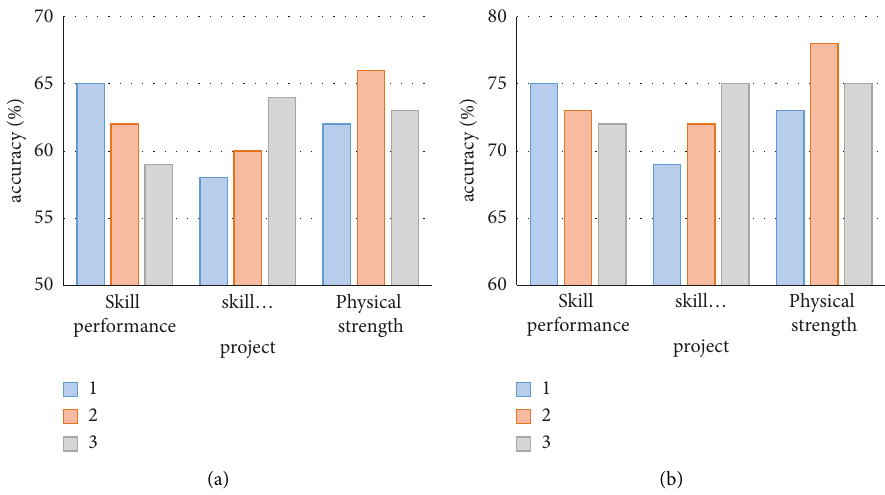
Figure 8: Accuracy comparison. (a) Coaching Experience. (b) Machine Learning